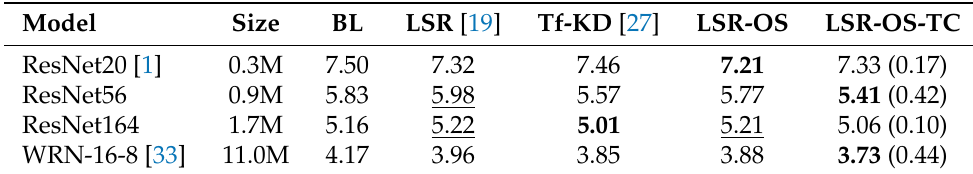
Table 2. Test set error rate comparison on the CIFAR-10 dataset.